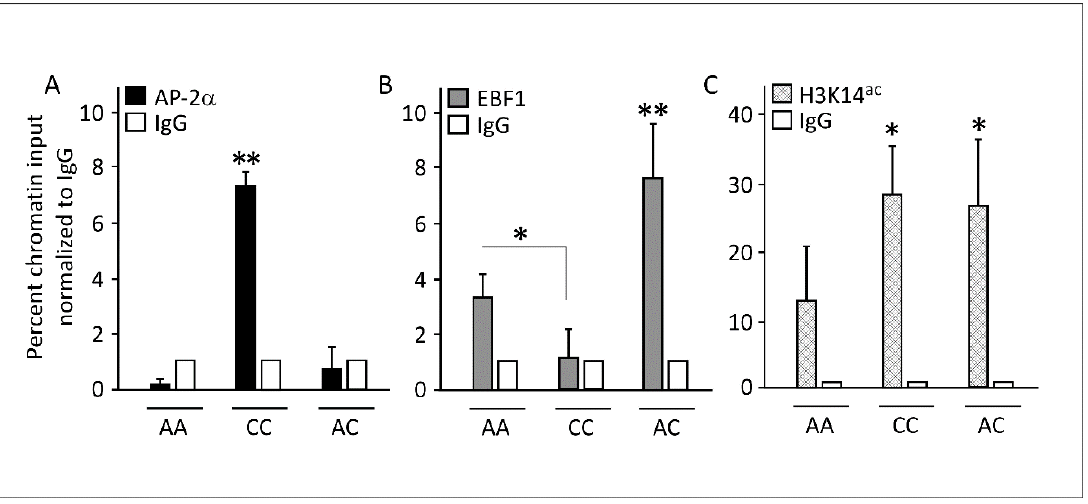
Figure 2. Binding of AP-2 α and EBF1 to CC and AA genotypes, respectively, mediated allele-specific active transcription. ( A ) ChIP analysis of AP-2 α at the CAV1 rs1997623 locus in preadipocytes isolated from three human individuals revealed that AP-2 α specific antibodies are bound and enriched chromatins in cells with genotype CC but not AA or AC. The binding at CC was significantly higher compared to AA; however, the binding at AC was not significantly higher compared to AA. ( B ) ChIP analysis of EBF1 binding at the CAV1 rs1997623 locus revealed significant binding enrichments at both AA and AC genotypes. The binding at AC was significantly higher compared to AA, however, the binding at CC was significantly lower compared to AA. ( C ) ChIP analysis of H3K14ac-specific antibodies at the CAV1 rs1997623 locus indicated active transcription in all cells independent of their genotype, albeit at different rates. Significant enrichments were found in the CC and AC genotypes when compared to the AA genotype. White bars designate genomic regions precipitated with IgG-nonspecific antibodies. Percentage chromatin input was calculated using real-time qPCR analysis and the locus-specific primers. Relative enrichment was calculated as the percent chromatin input normalized to IgG from three biological replicas ( n = 3). Two-tailed unpaired Student’s t -test was used to determine statistical significance. * p < 0.01, ** p < 0.001.